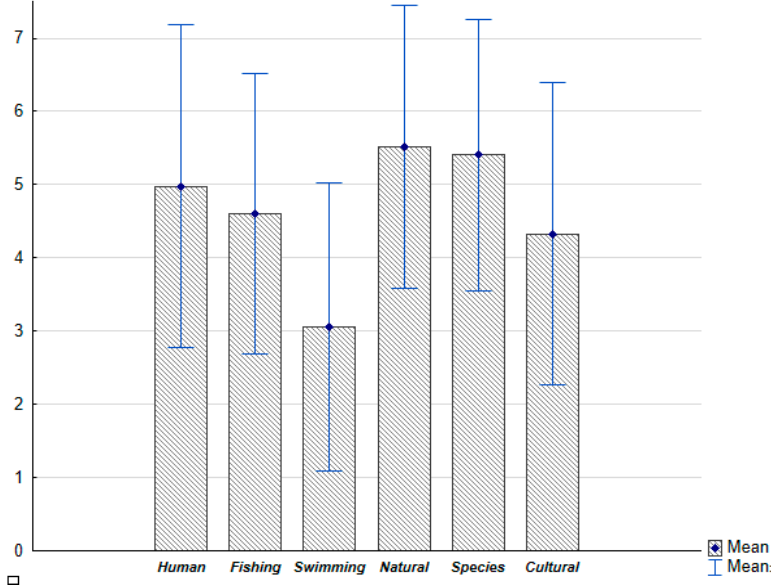
Figure 4. Degree of importance of different water uses scored by local people (N = 109).